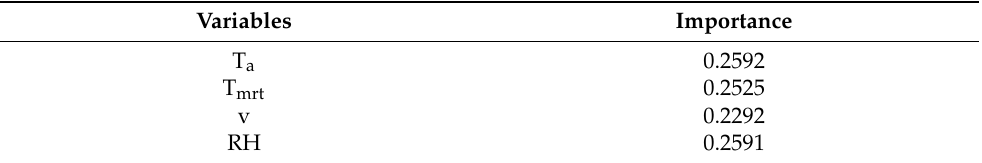
Table 9. Results of the variables of relative importance